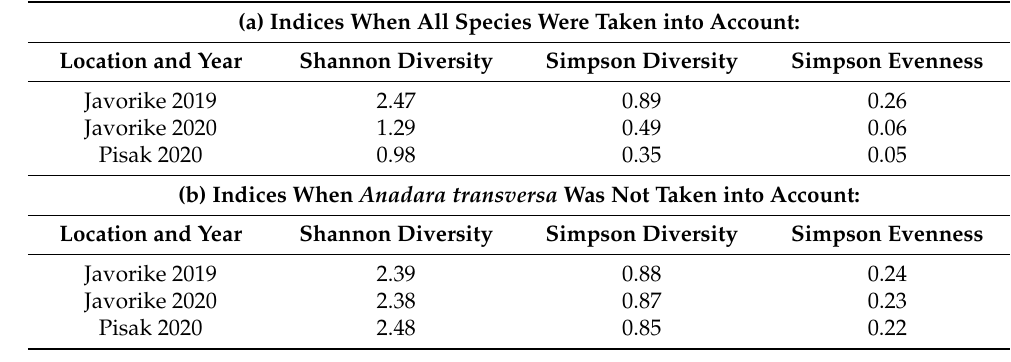
Table 7. Diversity and uniformity of the fouling community on larval collectors (a) when all species were taken into account and (b) when Anadara transversa was excluded.